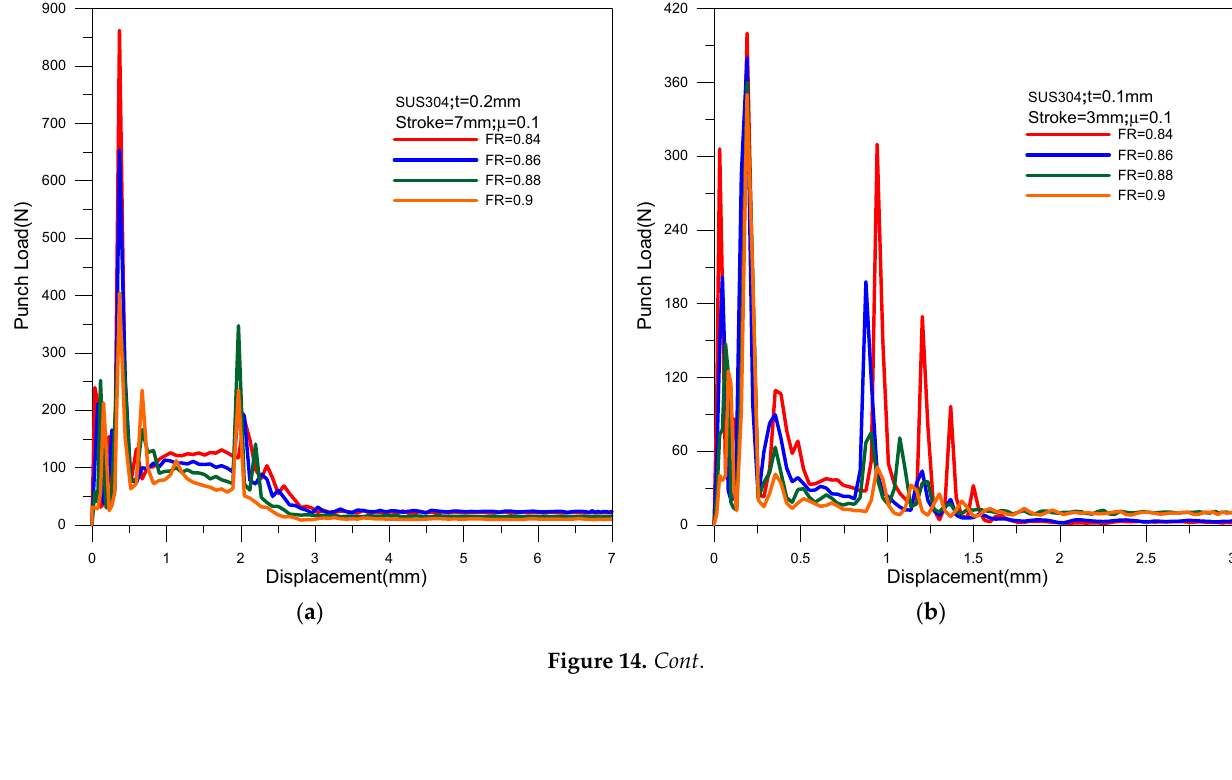
( c ) Figure 14. The relationship between the load and stroke of the punch with different FR : ( a ) Model 1; ( b ) Model 2; ( c ) Model 3. 4.3.2. The Relationship between the Forming Ratio and Maximum Principal Stress/Strain Figure 15 shows the relationship between the forming ratio and the maximum prin- cipal stress in the flange. The maximum principal stress decreases with an increase in the forming ratio, and because the larger value of FR draws less material, the corresponding punch load is smaller, as is the induced stress. After the punch retracts and the flange rebounds, the stress is released and reduced.